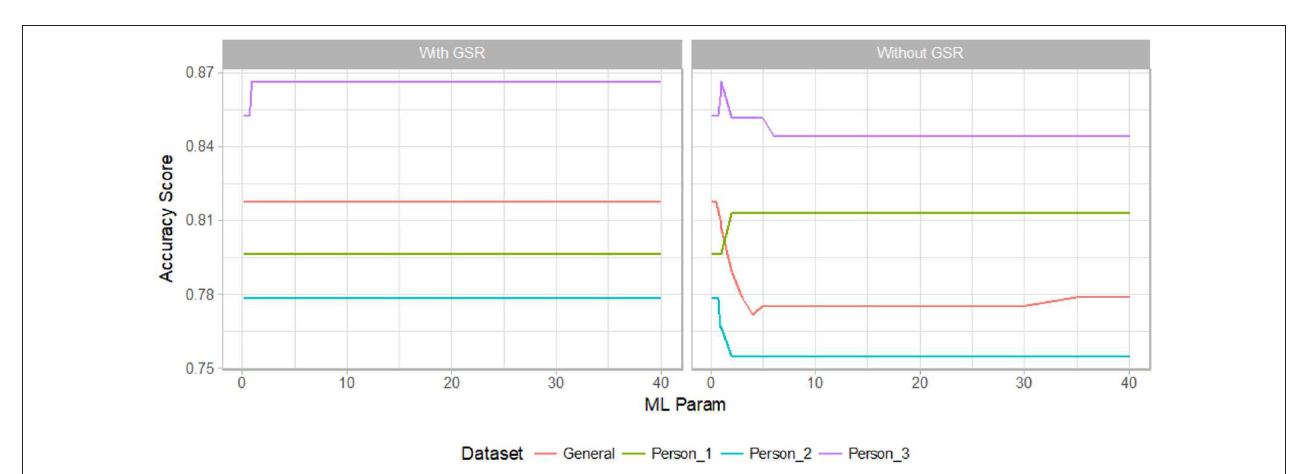
FIGURE 9 | Support vector machine with RBF kernel